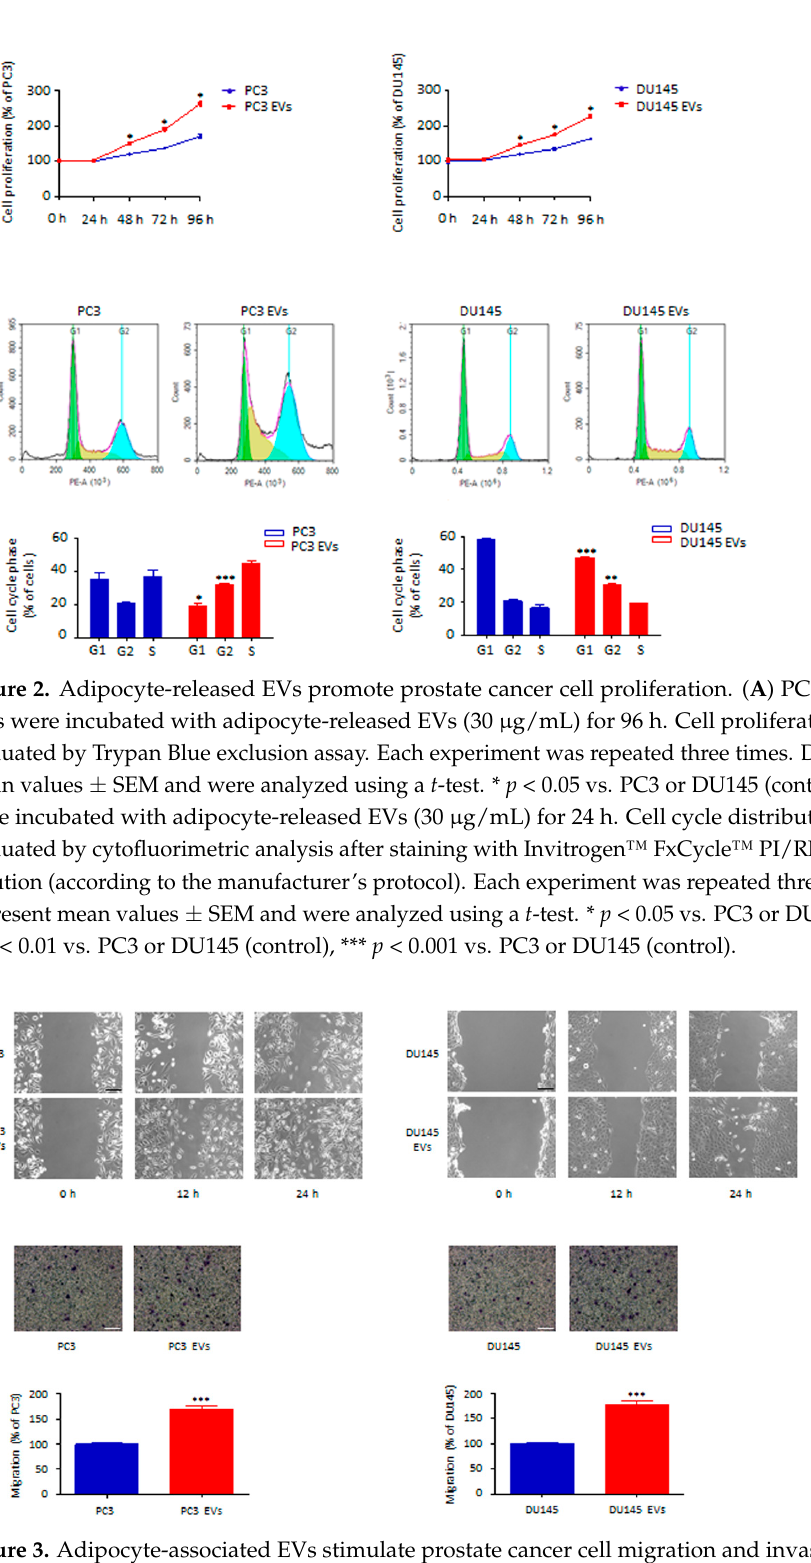
Figure 3. Adipocyte-associated EVs stimulate prostate cancer cell migration and invasion. ( A ) PC3 and DU145 cells were incubated with adipocyte-associated EVs (30 μ g/mL) for 24 h. Cell migration was then evaluated by wound healing assay. Each experiment was repeated three times. Scale bar is 200 μ m. ( B ) Cells were incubated with adipocyte-associated EVs (30 μ g/mL) for 24 h. Cell invasion was then evaluated by Boyden chamber assay. Each experiment was repeated three times. Scale bar is 100 μ m. Data represent mean values ± SEM and were analyzed using a t-test. *** p < 0.001 vs. PC3 or DU145 (control).